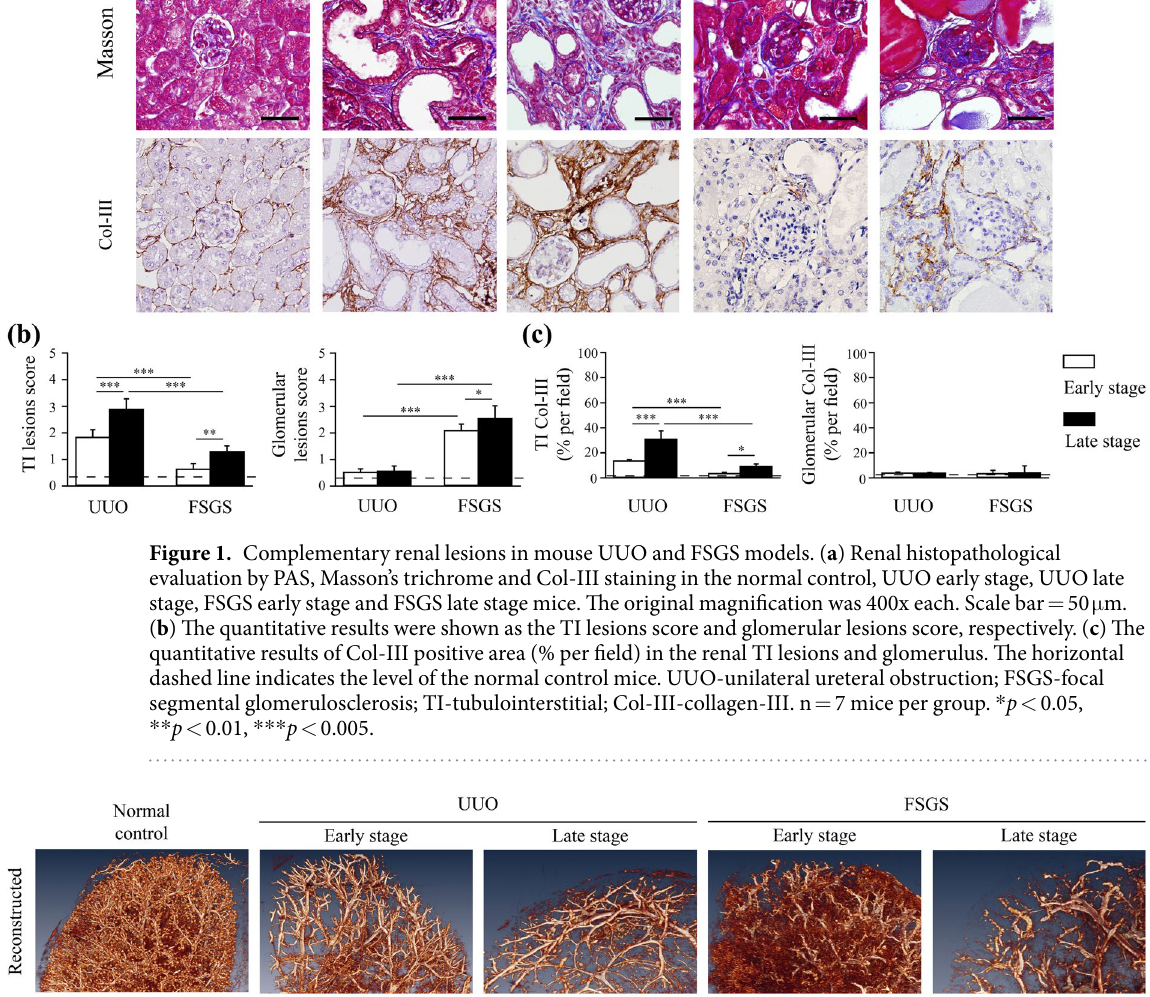
Figure 2. Reconstructed 3D renal microvasculature using synchrotron microtomography. Overview of the renal tomographic images from the normal control, UUO early stage, UUO late stage, FSGS early stage and FSGS late stage mice. UUO-unilateral ureteral obstruction; FSGS-focal segmental glomerulosclerosis. n = 7 mice per